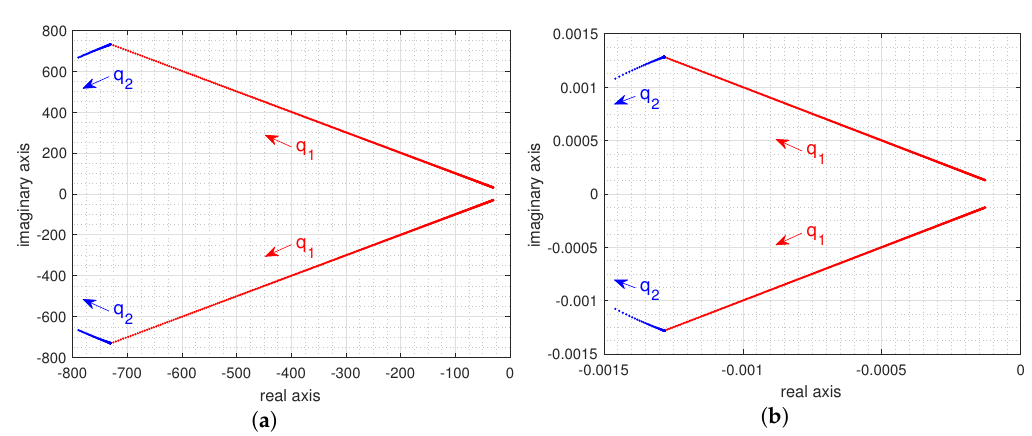
Figure 11. Poles of ( a ) the power, and ( b ) the state-of-charge (SOC) loops of